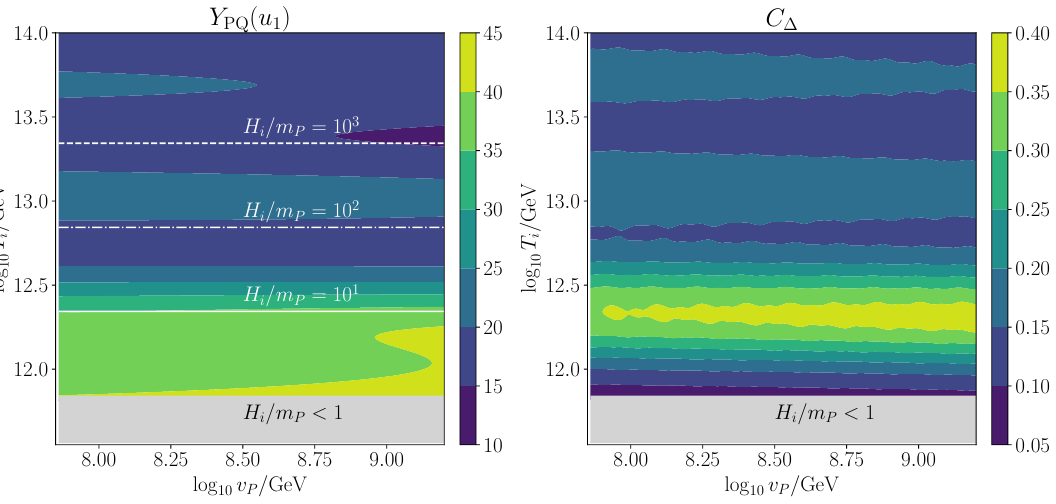
Figure 2 . Values of Y PQ ( u 1 ) (left) and C ∆ (right), where n = 10 , θ i = π/ 20 and m P = 10 6 GeV. H i /m P is shown by the white lines in the left